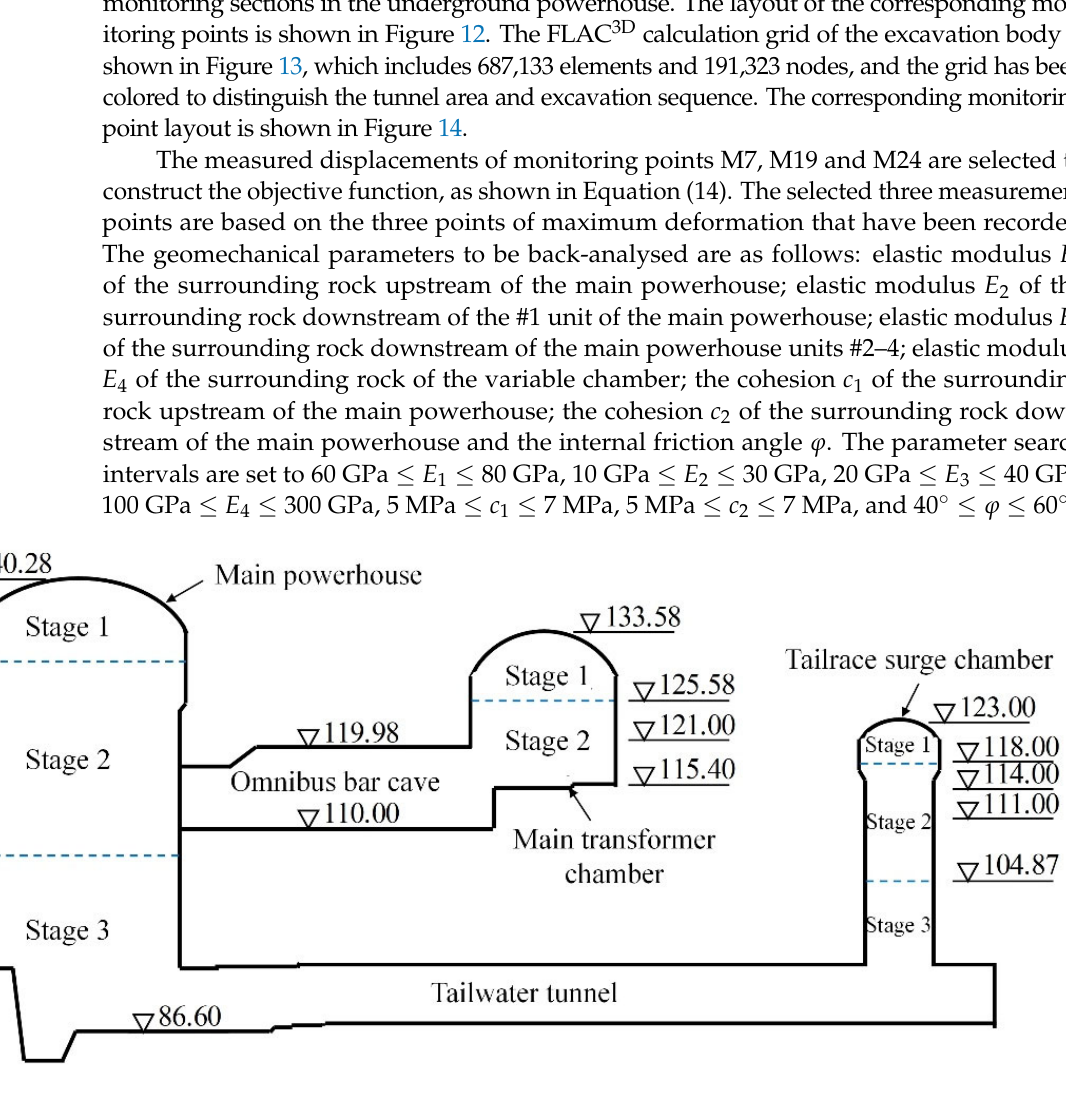
Figure 11. Schematic diagram of excavation by stages of the powerhouse (unit: m).